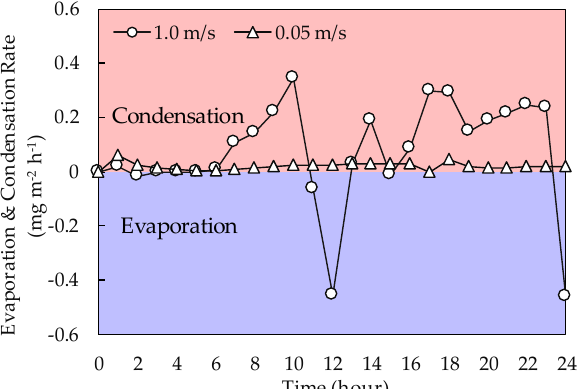
Figure 15. Variation in the average evaporation and condensation rate on the surface of the underfloor space during a day.